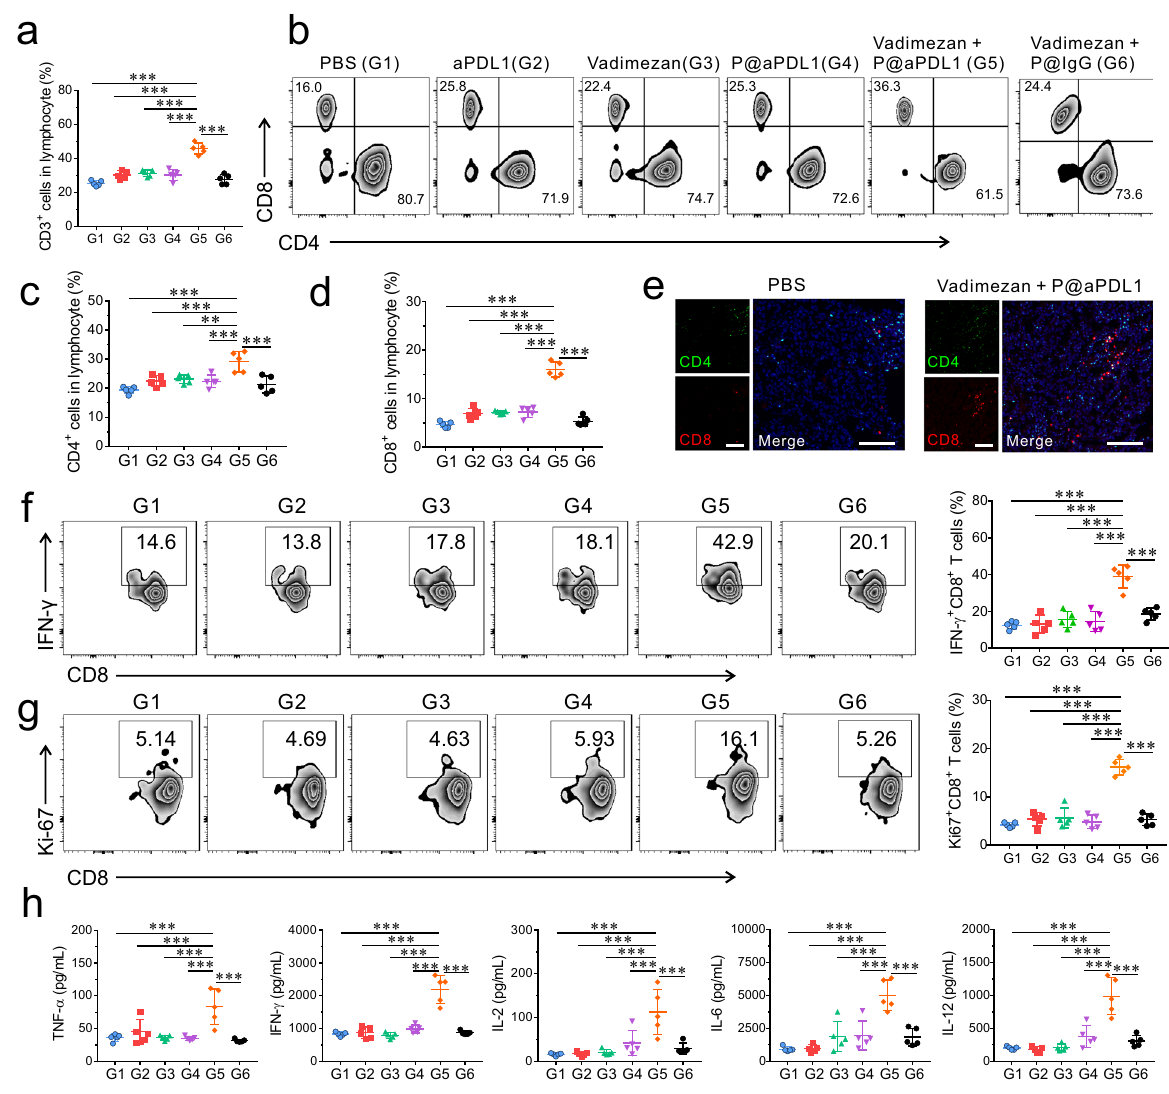
Fig. 4 Immune responses post P@aPDL1 and Vadimezan treatment in the 4T1 tumour model. a Relative quanti fi cation of the CD3 + T cells in the PB, n = 5 biologically independent animals. b Representative fl ow cytometry analysis of CD4 + T cells, CD8 + T cells gating on CD3 + T cells. Relative quanti fi cation of the c CD4 + T cells and d CD8 + T cells, n = 5 biologically independent animals. e Representative immuno fl uorescence images of metastatic tumour in the lung showing CD4 + T cells (green) and CD8 + T cells (red) after treatment, scale bar: 100 µ m. Representative fl ow cytometry analysis of f IFN- γ + CD8 + T cells and g Ki-67 + CD8 + T cells gating on CD3 + T cells, n = 5 biologically independent animals. h Cytokine levels in the serum of mice, n = 5 biologically independent animals. G1, PBS; G2, aPDL1; G3, Vadimezan; G4, P@aPDL1; G5, P@aPDL1 + Vadimezan; G6, P@IgG + Vadimezan. Data are presented as mean ± SD, statistical signi fi cance was analysed via ANOVA (one-way, Tukey post-hoc test). P -value: ** P < 0.01, *** P < 0.001. a G1 vs. G5: P < 0.0001, G2 vs. G5: P < 0.0001, G3 vs. G5: P < 0.0001, G4 vs. G5: P < 0.0001, G6 vs. G5: P < 0.0001. c G1 vs. G5: P < 0.0001, G2 vs. G5: P = 0.0007, G3 vs. G5: P = 0.0018, G4 vs. G5: P = 0.0005, G6 vs. G5: P < 0.0001. d G1 vs. G5: P < 0.0001, G2 vs. G5: P < 0.0001, G3 vs. G5: P < 0.0001, G4 vs. G5: P < 0.0001, G6 vs. G5: P < 0.0001. f G1 vs. G5: P < 0.0001, G2 vs. G5: P < 0.0001, G3 vs. G5: P < 0.0001, G4 vs. G5: P < 0.0001, G6 vs. G5: P < 0.0001. g G1 vs. G5: P < 0.0001, G2 vs. G5: P < 0.0001, G3 vs. G5: P < 0.0001, G4 vs. G5: P < 0.0001, G6 vs. G5: P < 0.0001. h TNF- α : G1 vs. G5: P < 0.0001, G2 vs. G5: P = 0.0009, G3 vs. G5: P < 0.0001, G4 vs. G5: P < 0.0001, G6 vs. G5: P < 0.0001; IFN- γ : G1 vs. G5: P < 0.0001, G2 vs. G5: P < 0.0001, G3 vs. G5: P < 0.0001, G4 vs. G5: P < 0.0001, G6 vs. G5: P < 0.0001; IL-2: G1 vs. G5: P < 0.0001, G2 vs. G5: P < 0.0001, G3 vs. G5: P < 0.0001, G4 vs. G5: P = 0.0007, G6 vs. G5: P < 0.0001; IL-6: G1 vs. G5: P < 0.0001, G2 vs. G5: P < 0.0001, G3 vs. G5: P < 0.0001, G4 vs. G5: P < 0.0001, G6 vs. G5: P < 0.0001; IL-12: G1 vs. G5: P < 0.0001, G2 vs. G5: P < 0.0001, G3 vs. G5: P < 0.0001, G4 vs. G5: P < 0.0001, G6 vs. G5: P < 0.0001.